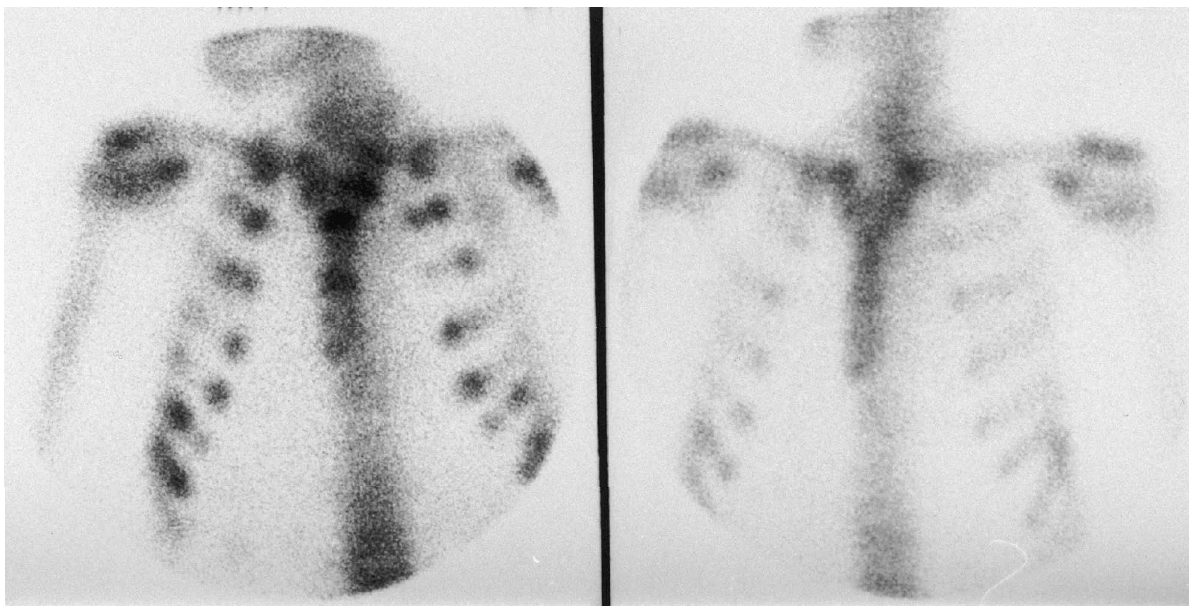
Fig. 3. 99-Tc isotope bone scans. (Left) pre-therapy with multiple metastases and (right) post-therapy with resolution and remission metastases, the median survival from date of primary diagnosis was 21 months (range 6–56 months).